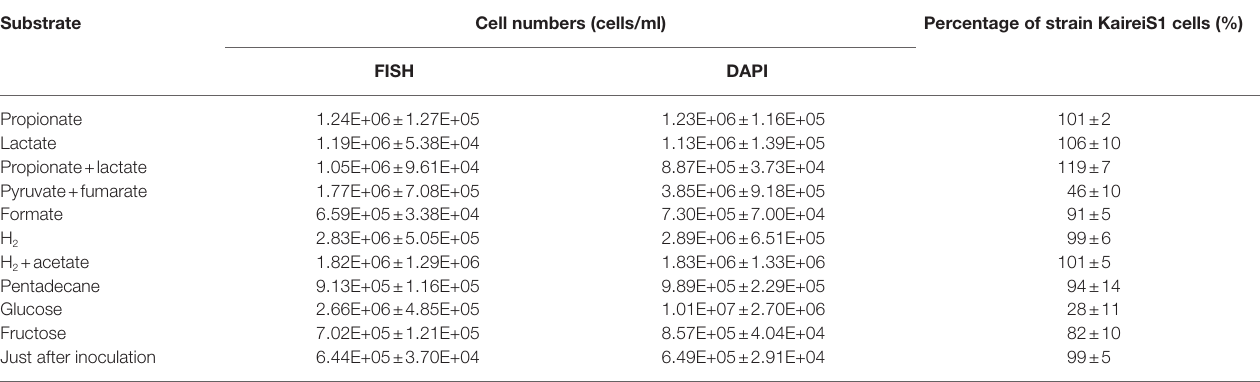
TABLE 1 | Cell counts of the cultures growing with different